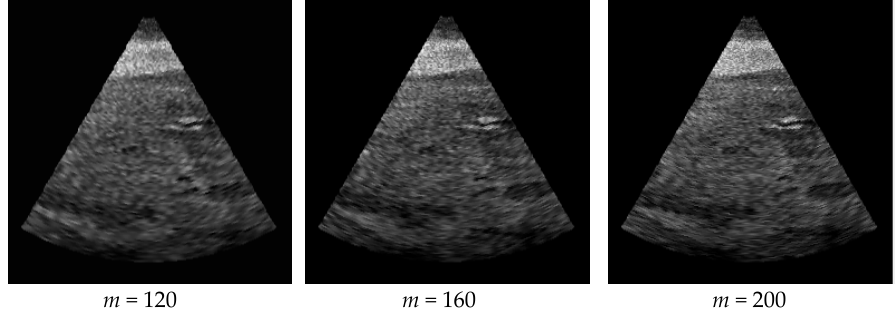
Figure 6. Effect of changing axial resolution ( m ) in radial-uniform sampling ([13], reproduced with permission).